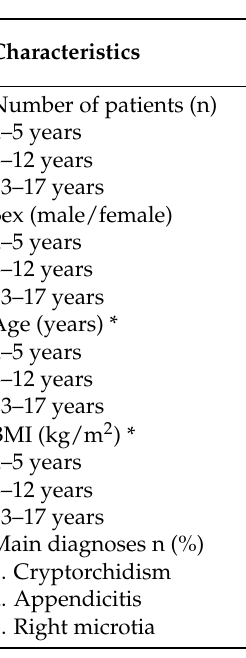
Table 1. Demographic characteristics of the patients undergoing minor